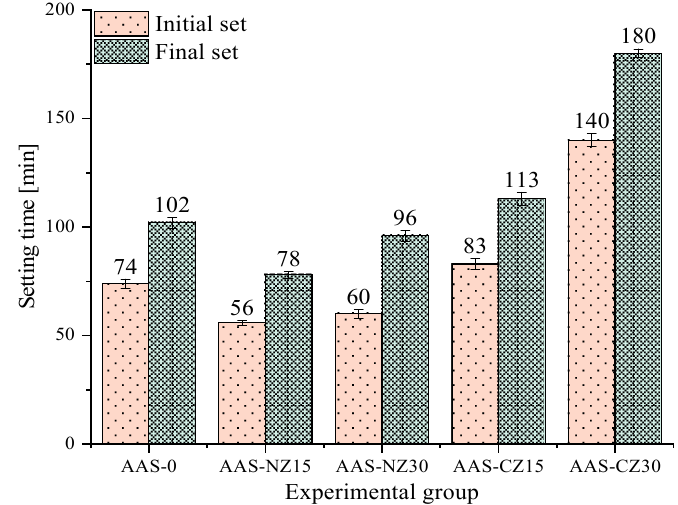
Figure 2. The setting times of all of the alkali-activated slag (AAS) mortars.